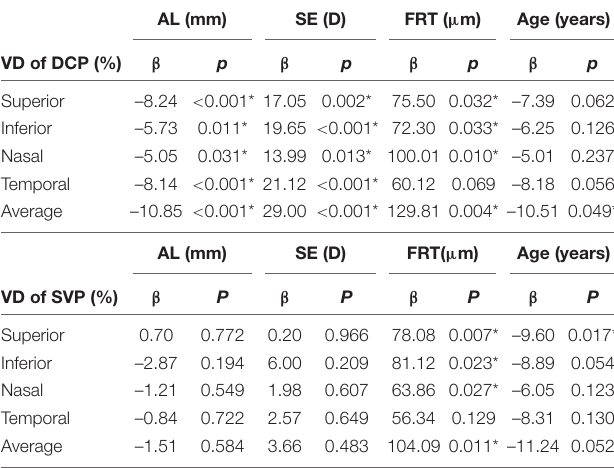
TABLE 4 | Univariate regression between parafoveal retinal vessel density and axial length, spherical equivalent, foveal retinal thickness, age. AL (mm) SE (D) FRT ( µ m)